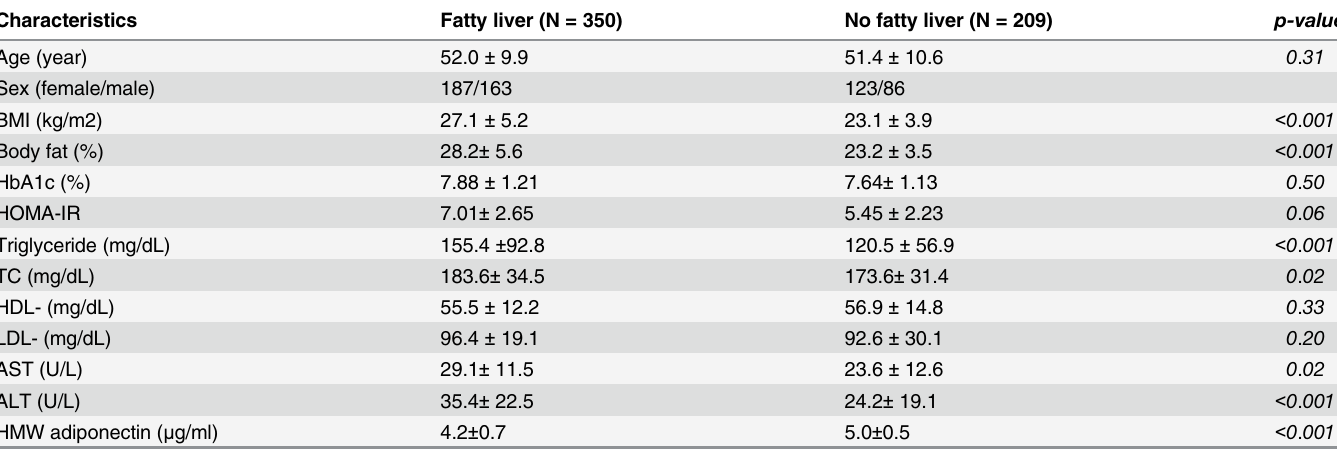
Table 1. Demographic and clinical data of the